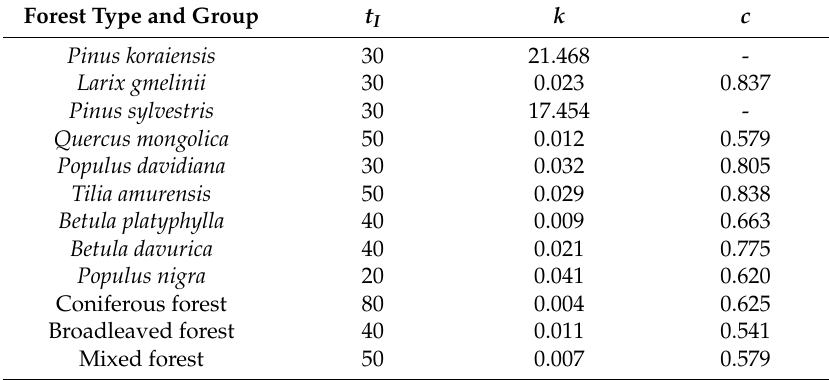
Table 2. Coefficient estimates for Equations (1) and (2) for nine forest types and three forest type groups. t I is the base stand age in years, and k and c are regression